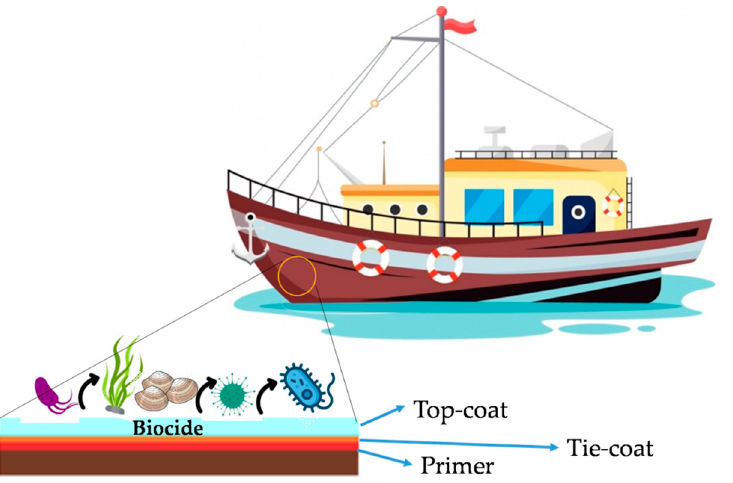
Figure 4. Antifouling topcoat based on molecules with biocidal action.